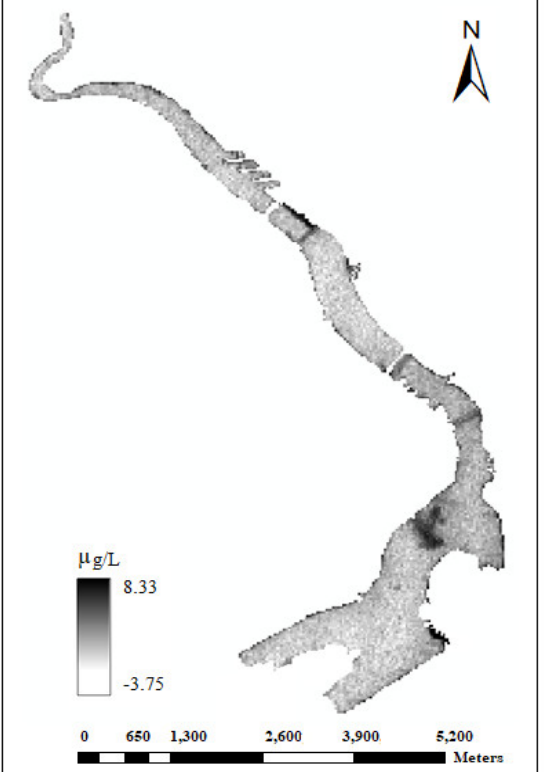
Figure 4. The residual (differences between spectral chlorophyll-a originating from WorldView-2 and Landsat images) map.